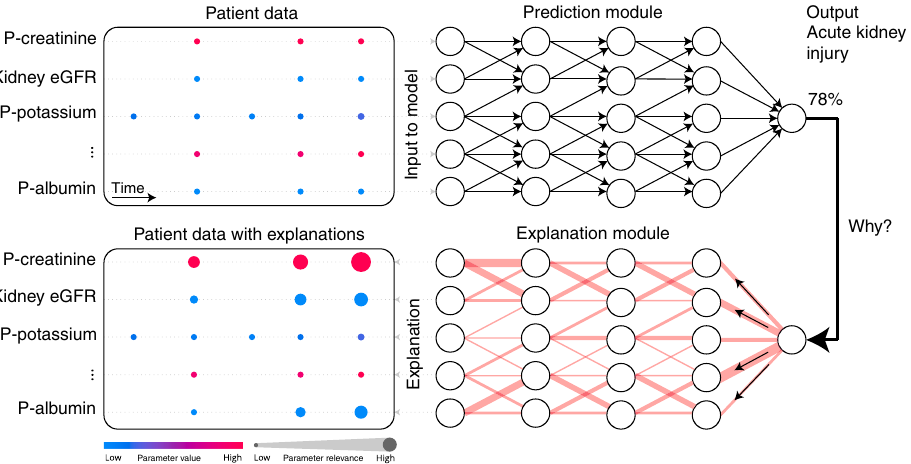
Fig. 1 Overview of the xAI-EWS system. Each patient ’ s data from the EHR is used as input in the TCN prediction module. Based on this data, the model makes a prediction, such as a 78% risk of AKI. The DTD explanation module then explains the TCN predictions in terms of input variables. P, plasma; eGFR, estimated Glomerular fi ltration rate; DTD, deep Taylor decomposition; TCN, temporal convolutional network; xAI-EWS, explainable arti fi cial intelligence early warning